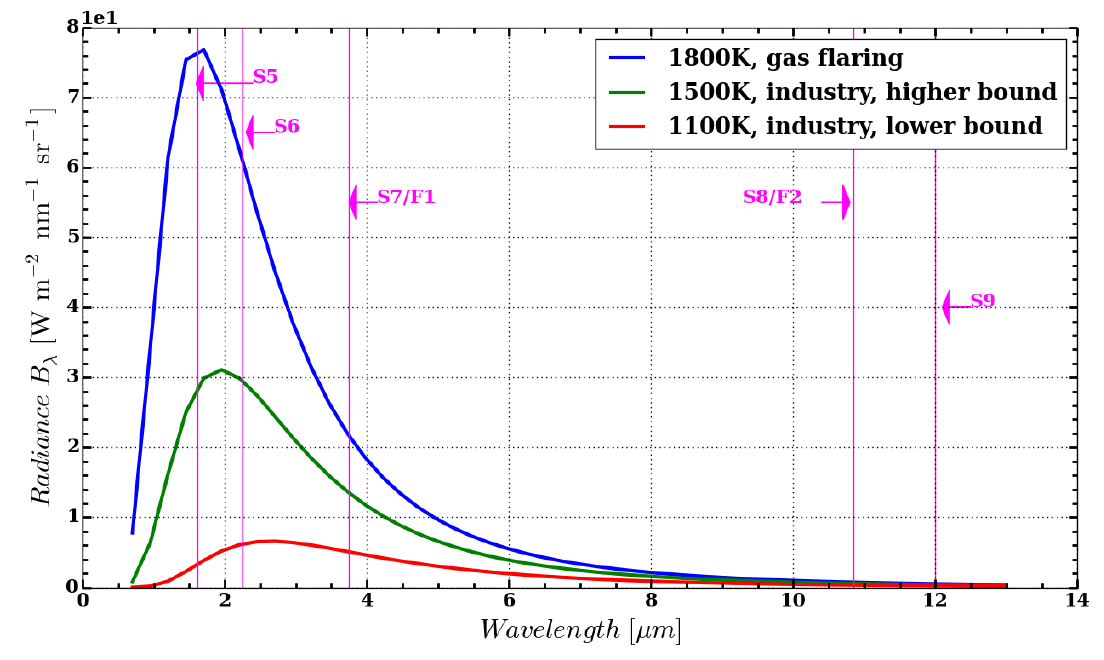
Figure 2. Planck curves for typical industrial processes and gas flaring temperatures, together with SLSTR SWIR (S5 and S6), MIR (S7 and F1) and TIR (S8, S9 and F2) channels. Temperatures of 1100 K and 1500 K represent, roughly, the lower and upper bounds of the operating temperatures of blast furnaces. 1800 K is a typical gas flaring